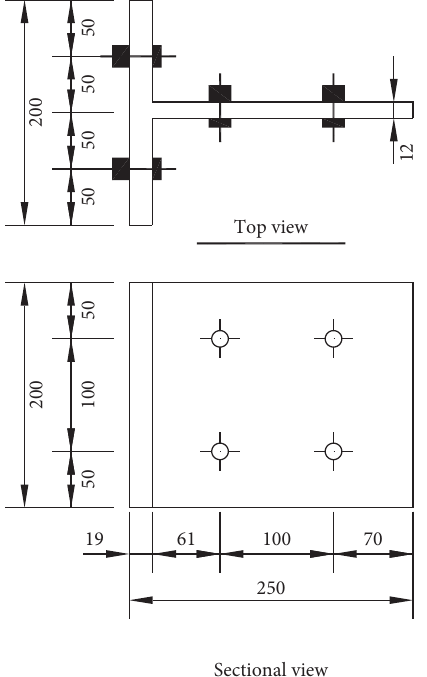
Figure 6: Geometry and dimensions of the T-stub (in